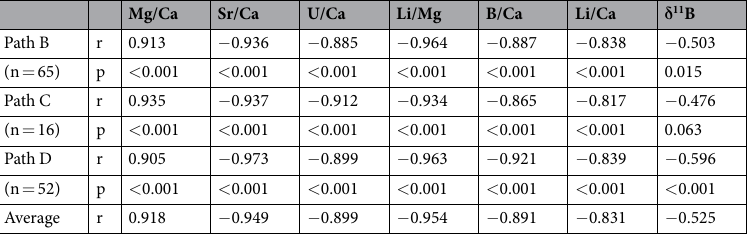
Table 1. Pearson correlation coefficients (r) and corresponding p-values for the relationships between TE’s and δ 11 B coral bimonthly records with the bimonthly seawater temperature record. The anomalous data associated with the 1998 thermal stress event was not included in the calculations.